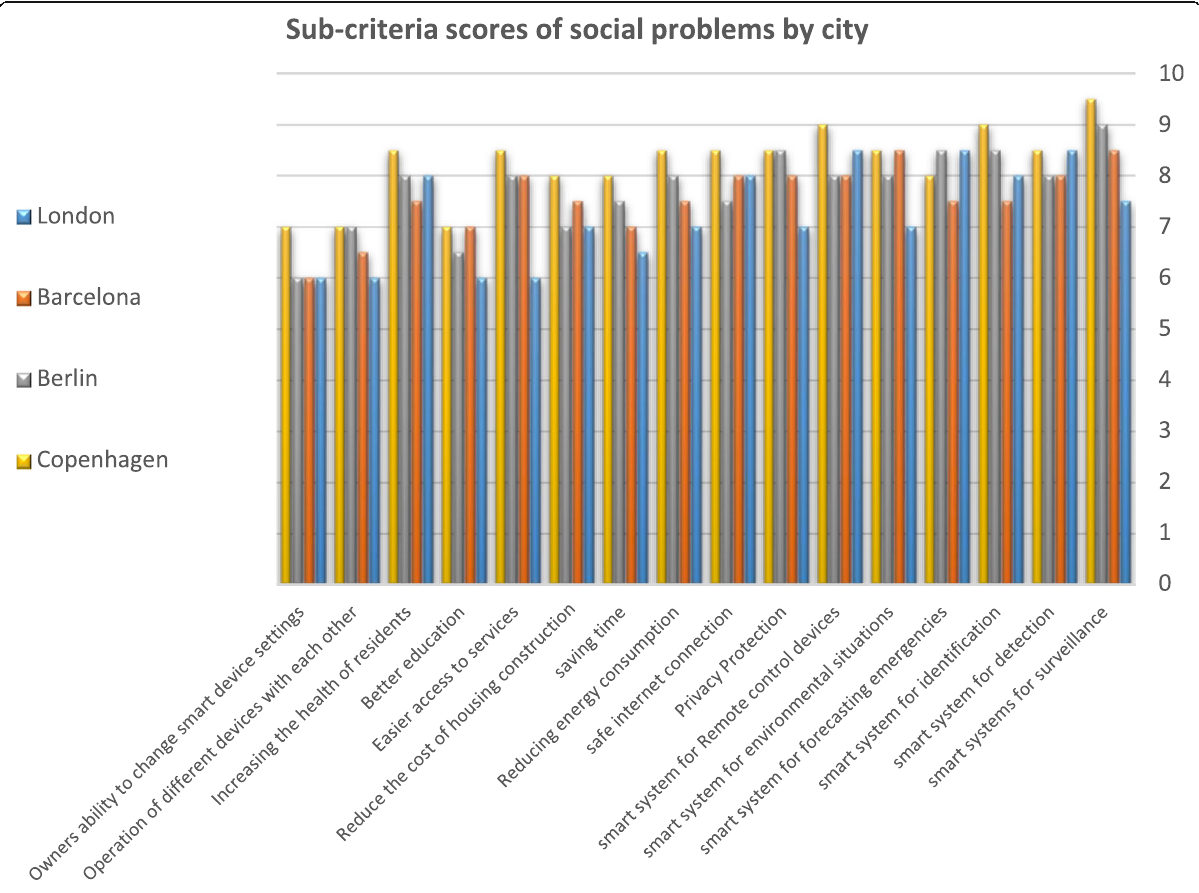
Fig. 6 Sub-criteria scores of social problems by city. Source “ by the author